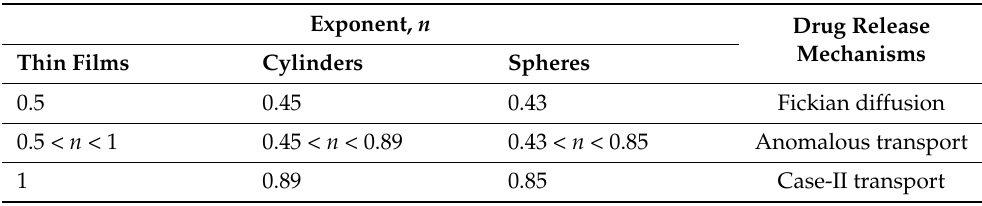
Table 4. Exponent n and the drug release mechanism from the controlled-drug-delivery carriers of different geometry